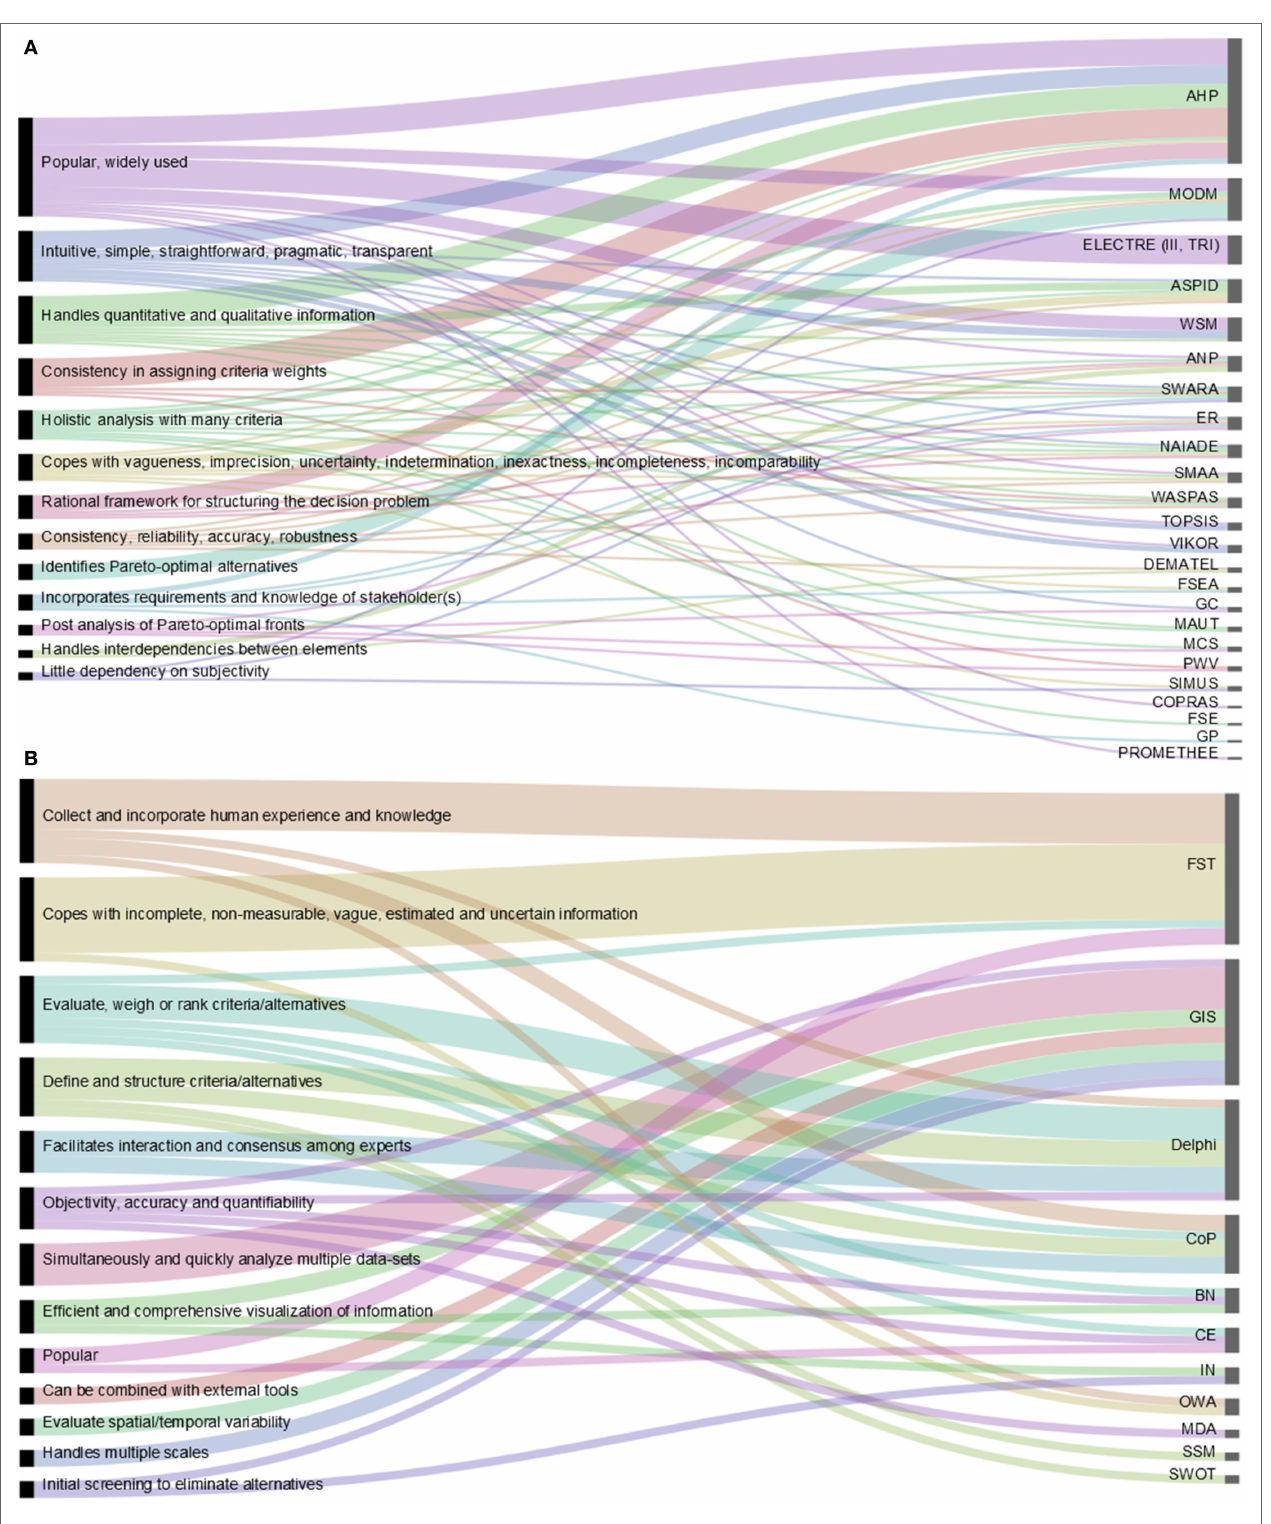
FiGURe 11 | Stated arguments for selecting the respective (A) multicriteria decision analysis methods and (B) supporting methods . Note: HAWM, MAVT, MEW, RWOT, and QCBS are not represented, as no explicit arguments were provided in the studies.